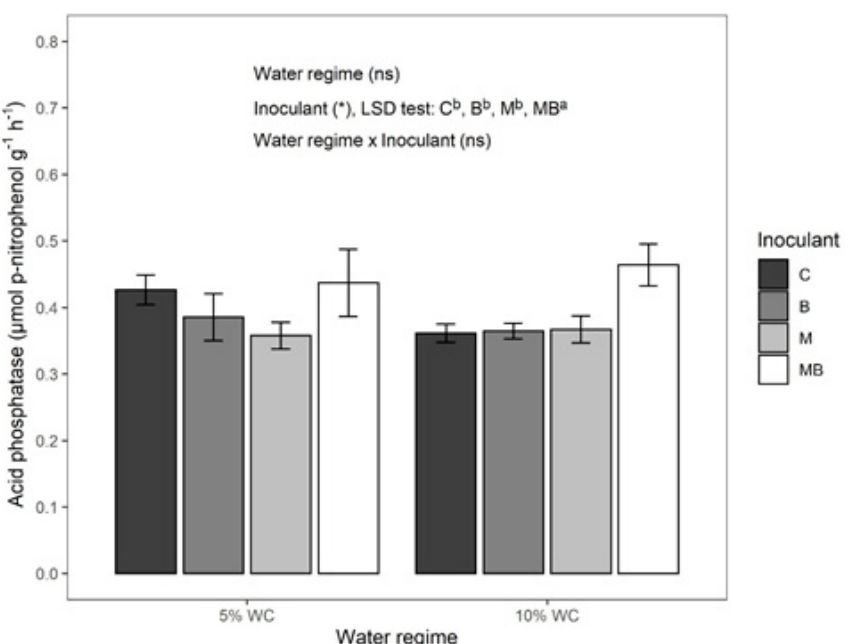
Figure 4. Mean values ( ± SE) of acid phosphatase activity in rhizosphere soil samples of L. sativa under different water regimes. In the case of significant effects (* p < 0.05), the results of the post hoc comparisons are presented; different superscript letters denote significant differences (C = Control, B = B. subtilis , M = AMF, MB = AMF and B. subtilis ).